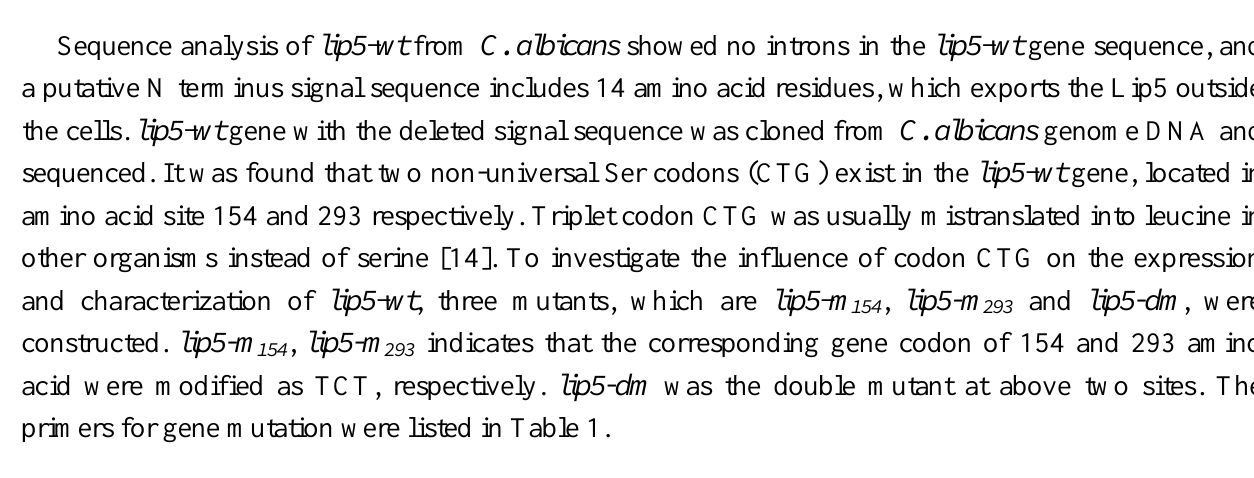
Table 1. Primers for lip5 gene cloning and